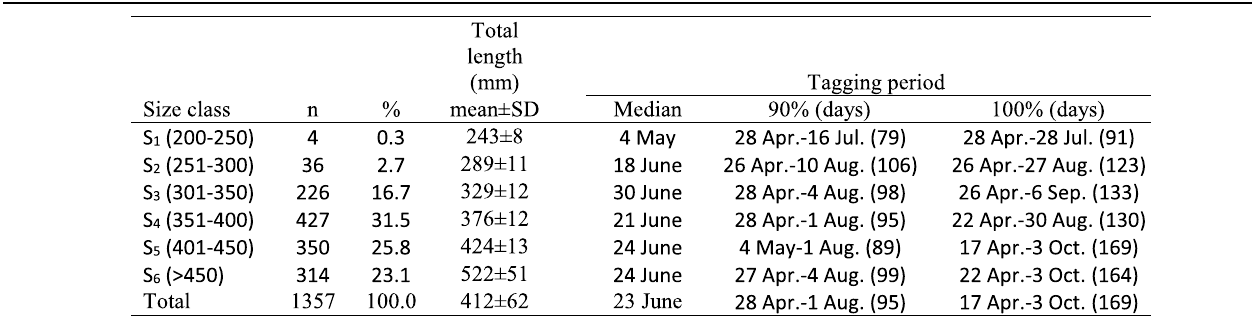
Table 2. Tagging period according to size classes of the tagged yellow